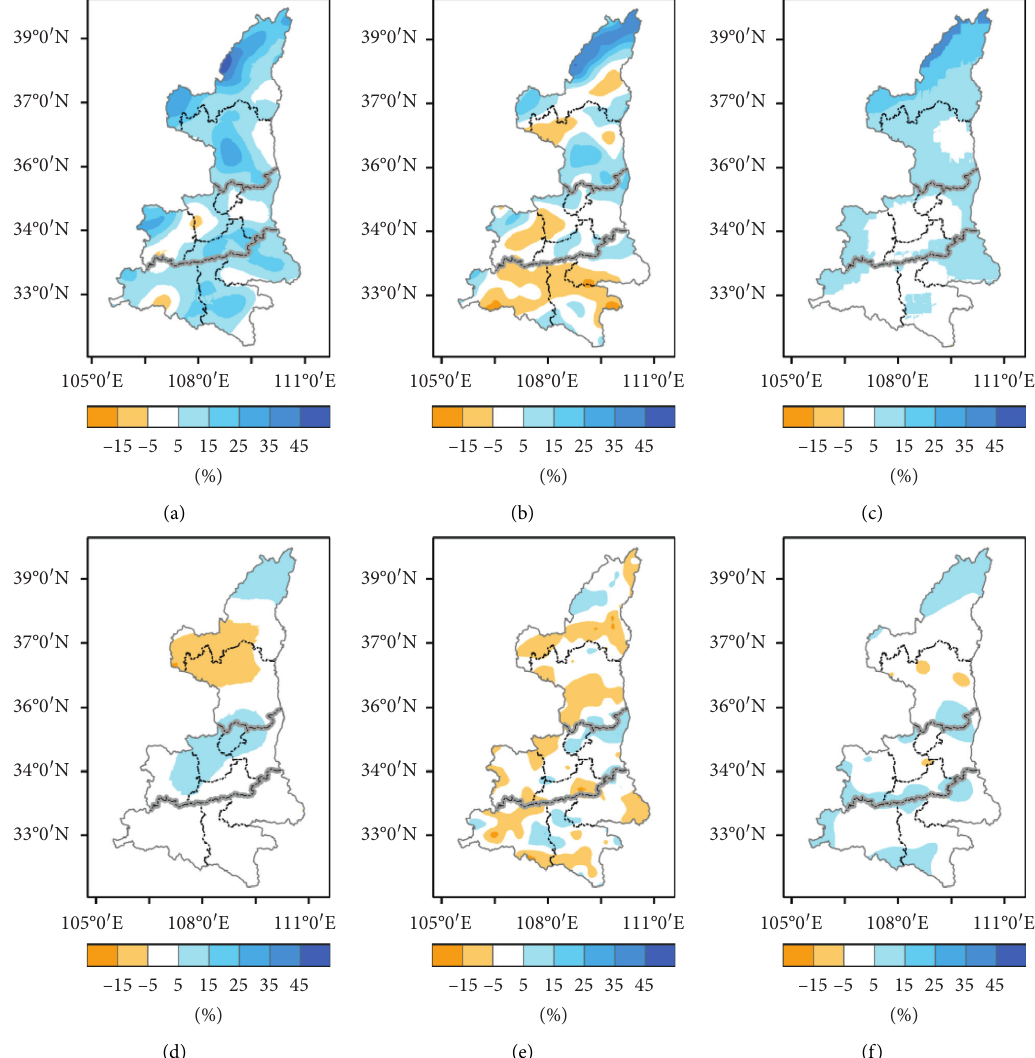
Figure 8: Spatial changes of six EPIs over Shaanxi Province for the mid-21st century (relative to 1986–2005 period): (a) Rx1day; (b) Rx5day; (c) R95p; (d) R10 mm; (e) CDD; (f)